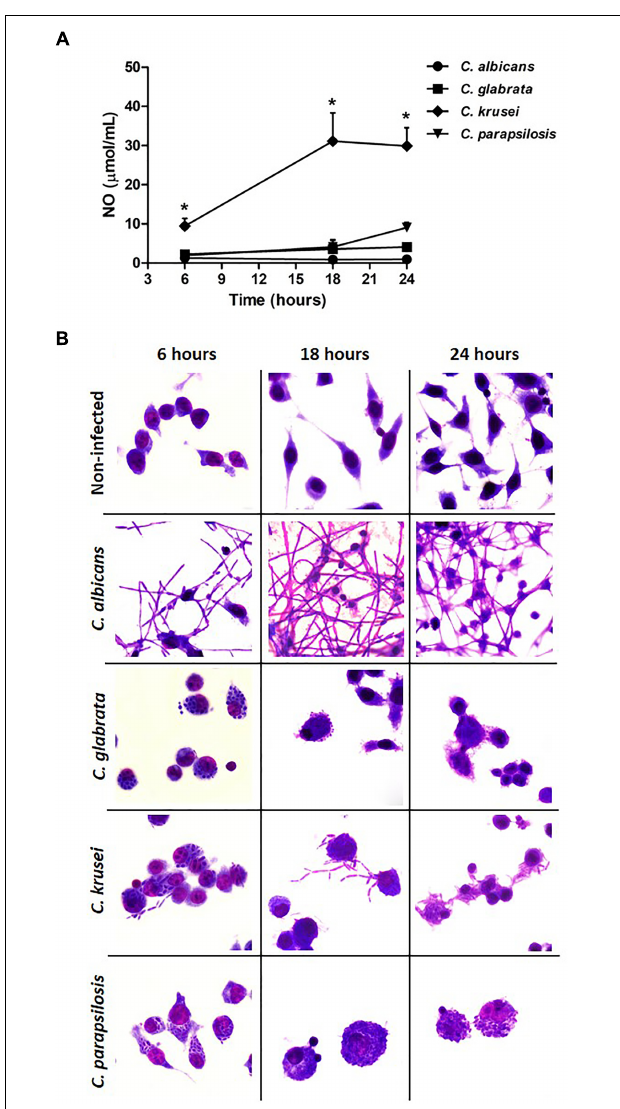
FIGURE 6 | Candida krusei triggers higher NO production and yeast-to-hyphae transition in microglia. Nitric oxide (NO) levels (A) were measured in the supernatant of microglial cell (5 × 10 5 /well) co-cultured with C. albicans , C. glabrata , C. krusei and C. parapsilosis (5 × 10 5 yeasts/well) at 6, 18, and 24 h after incubation (B) . The results are expressed as mean ± SEM ( ∗ indicate statistical difference among groups analyzed by One-way ANOVA with post hoc Tukey test; p < 0.05; n =